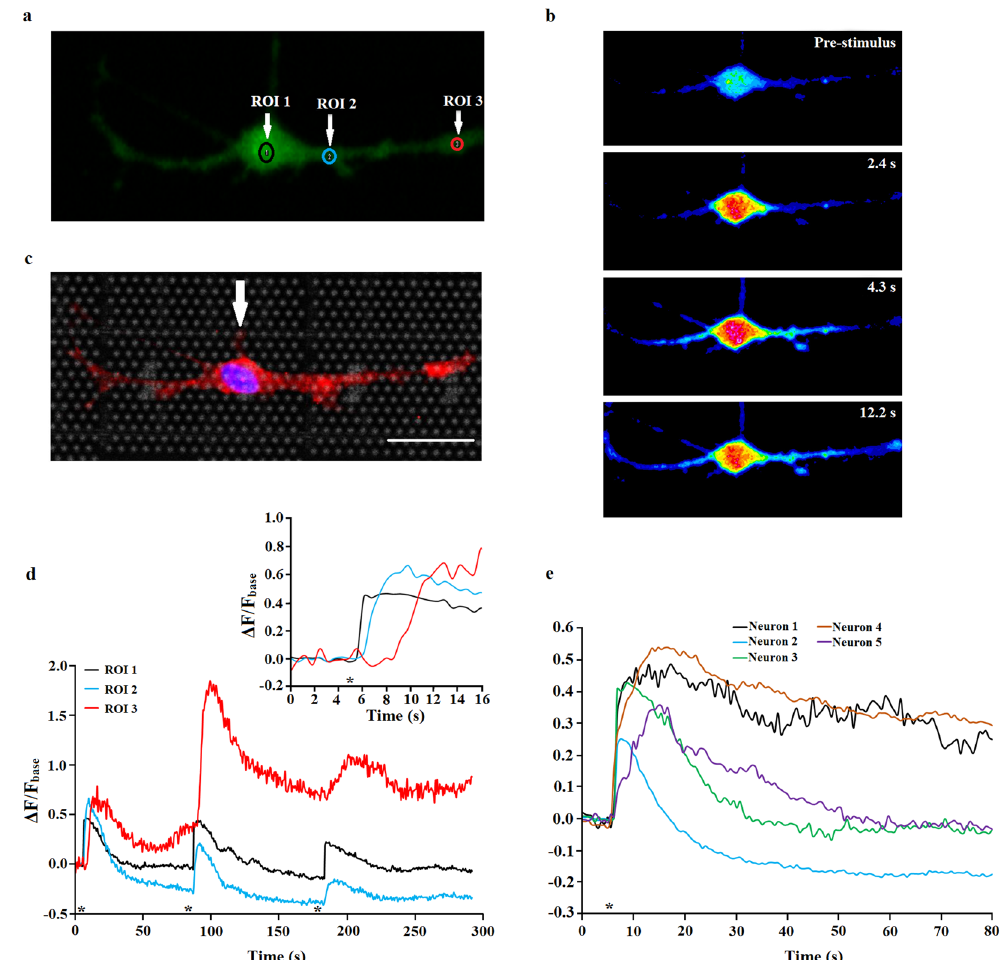
Figure 10. Fluo-4-AM calcium imaging and localized stimulation of SGN by biphasic electrical stimulation. ( a ) An image of a spiral ganglion neuron after Fluo4 calcium staining. Regions of interest are indicated with the yellow circles (ROI 1, ROI 2, ROI 3). ( b ) Time sequence of intracellular calcium concentration ([Ca 2 + ] i ) of a single SGN in response to electrical pulse train. Timing of the image capture is shown in upper right corner and is relative to the stimulus onset. ( c ) Fluorescent image of a spiral ganglion neuron stained with Tuj (neurons, red) and S-100 (glial cells, green). The stimulated cell was positive for neuronal marker Tuj only. The soma of the stimulated SGN lies directly on the top of the micro-electrode (white arrow). Scale bar: 25 µ m. ( d ) Relative changes in [Ca 2 + ] i in three regions of interest indicated in ( a ) by circles with corresponding color. The inset shows a magnification of the graph right after the first stimulation. * indicates the onset of the electrical pulse train. ( e ) Relative changes in [Ca 2 + ] i in five observed neurons indicated with the corresponding